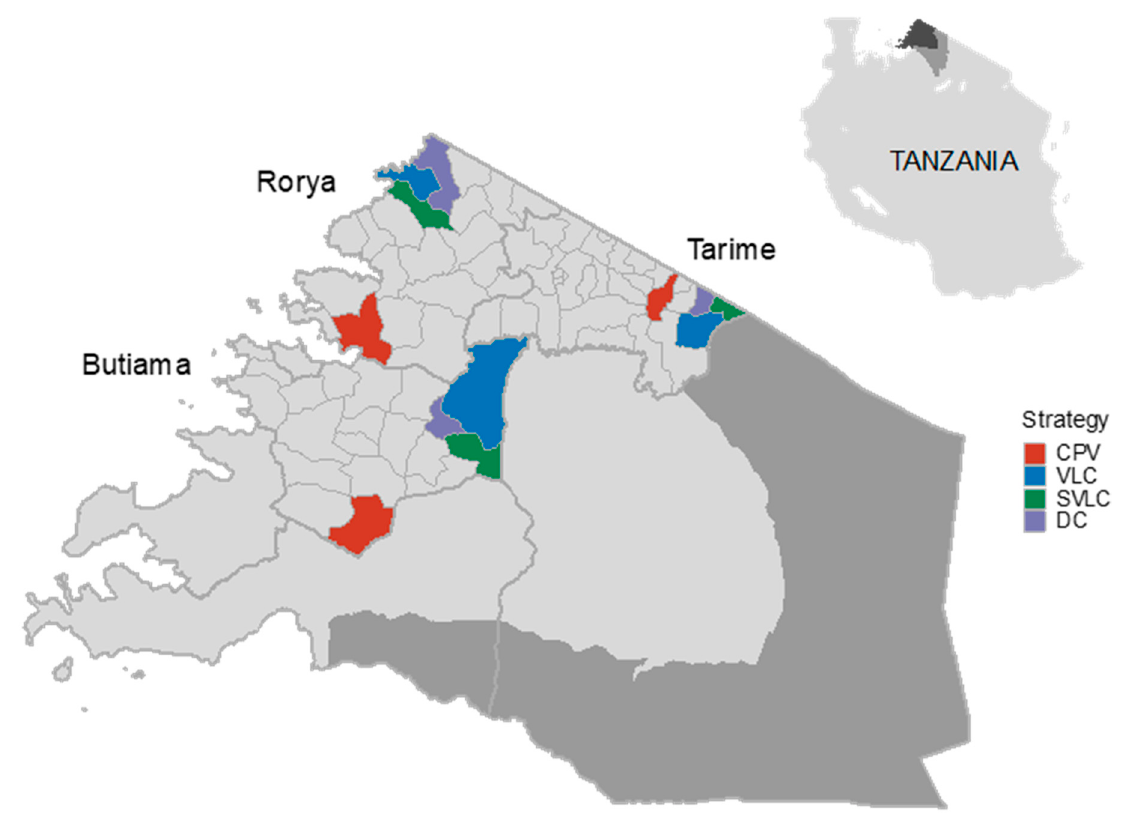
Figure 1. Map of the Mara region in Tanzania showing study wards and the assigned vaccination delivery approaches. Approaches comprised centralized pulsed vaccination (CPV), and three strategies of decentralized vaccination, specifically village-level continuous (VLC), sub-village level continuous (SVLC), and discretionary continuous (DC).